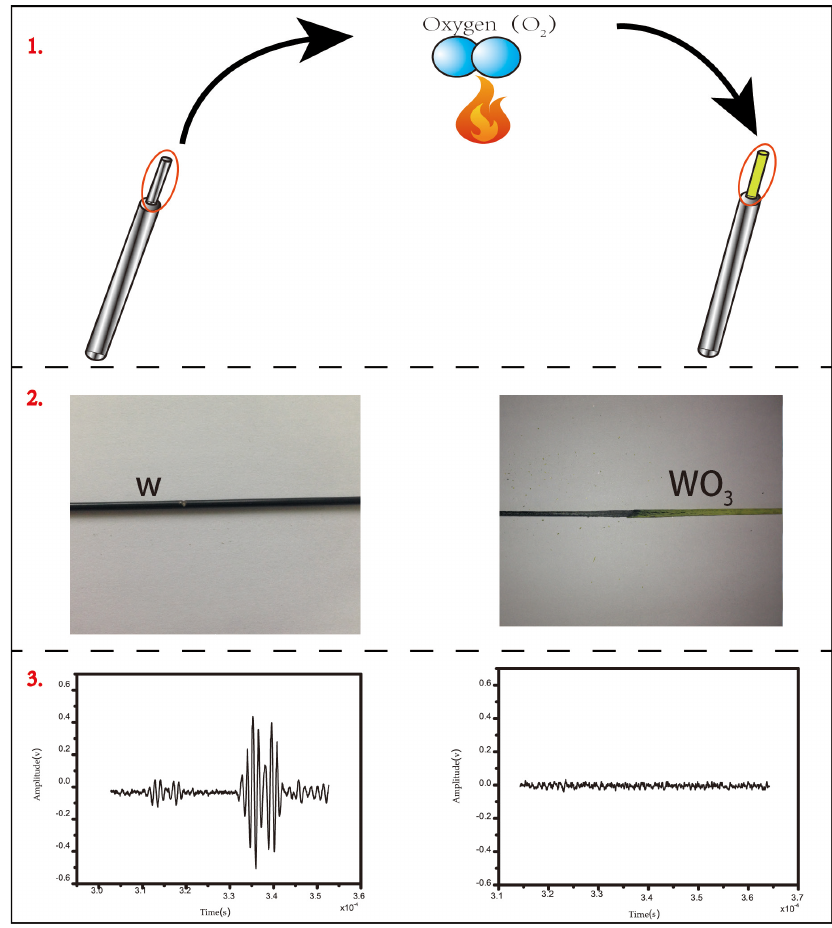
Figure 2. Schematic diagram of tungsten oxide generation.